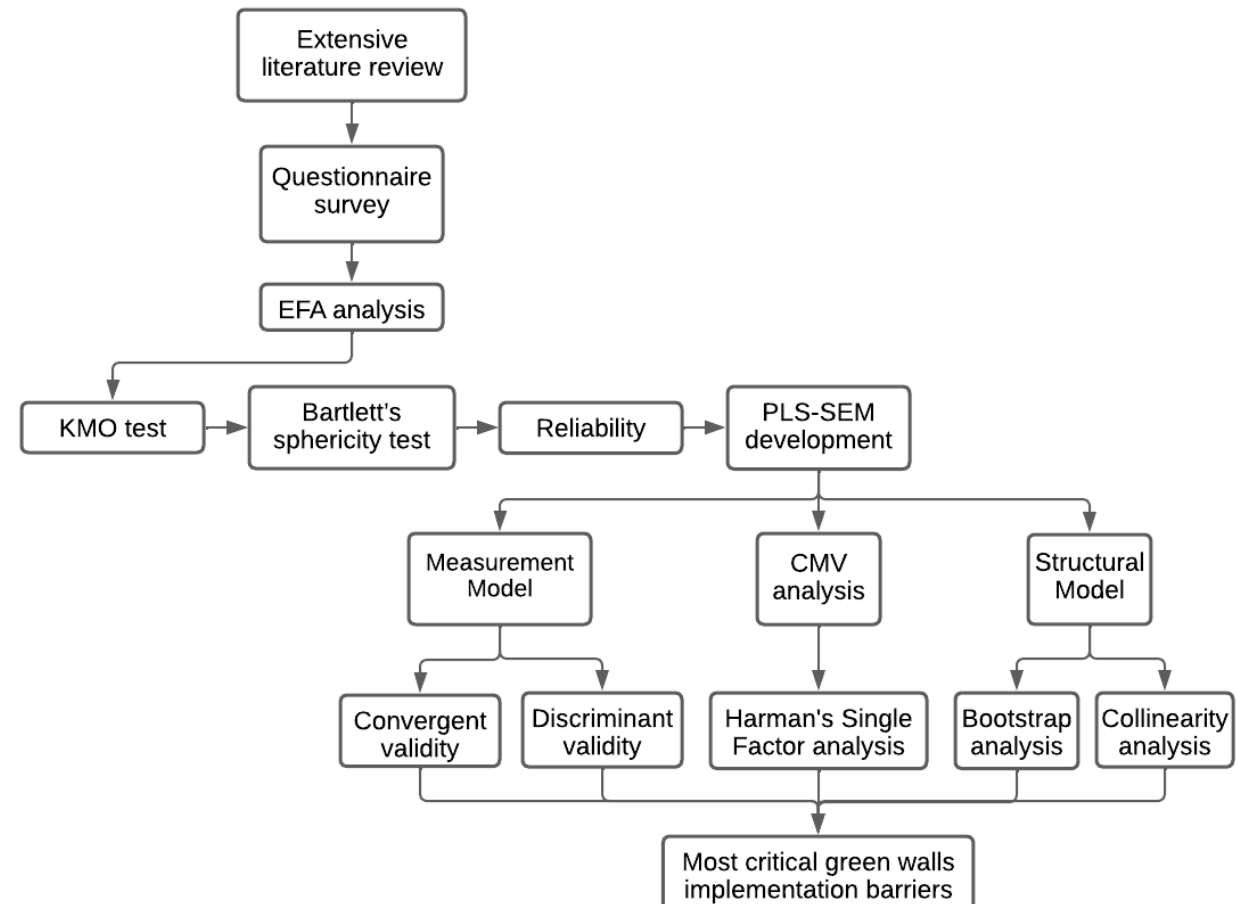
Figure 2. Research